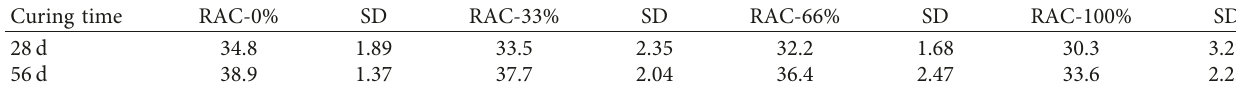
SD represents the standard deviation of the compressive strength values.